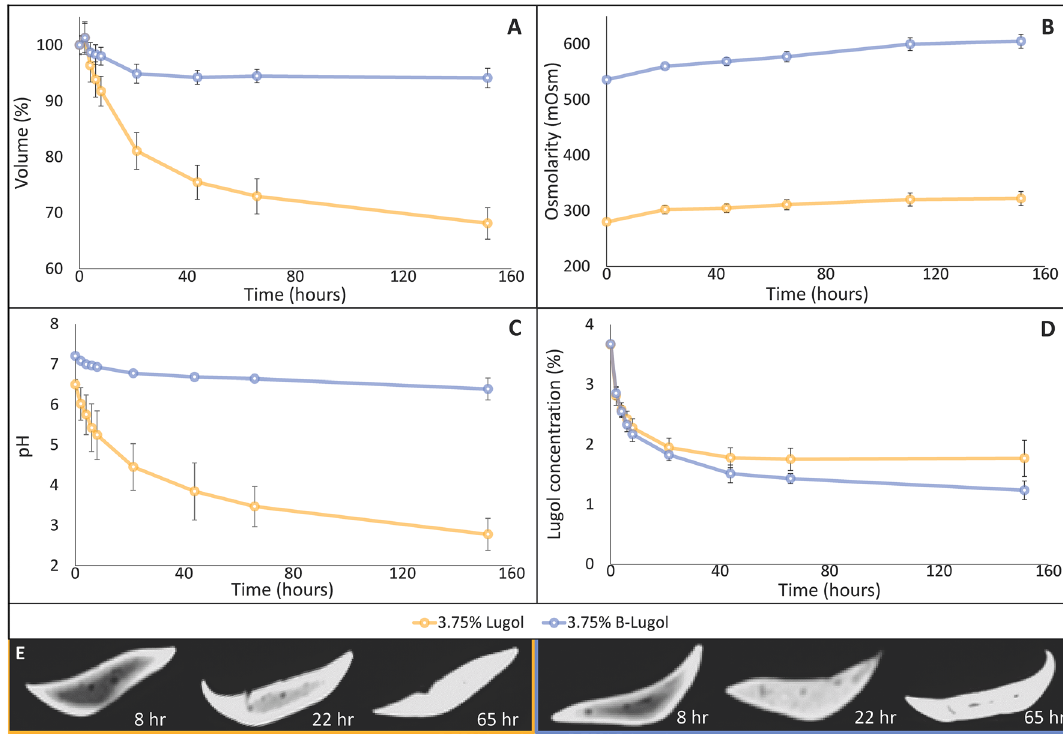
Figure 4. Comparison of staining of livers in 3.75% Lugol and 3.75% B-Lugol. The values are the average and standard deviation of 12 biological replicates. ( A ) Liver volume. The volume of the livers in B-Lugol decreased slightly during staining, whereas in Lugol the mouse liver volumes almost decreased to one third of the original volume. ( B ) Osmolarity. In both solutions the osmolarity increased over time. ( C ) pH . The pH of the Lugol’s solutions decreased significantly in both Lugol and B-Lugol, 6.50 ± 0.1 to 2.8 ± 0.4 and 7.2 ± 0.0 to 6.4 ± 0.3, respectively. However, in B-Lugol this decrease was small because of the buffering. ( D ) Lugol